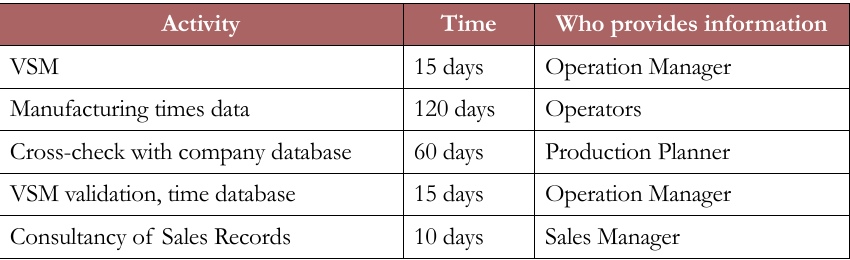
Table 2. Efforts and references of field